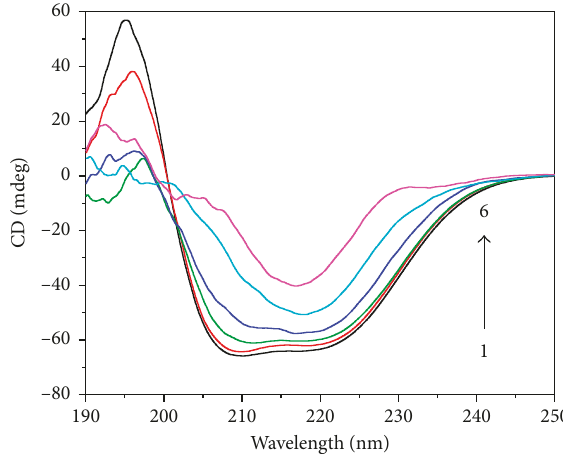
Figure 7: Far-UV CD spectra of HSA-compound system (HSA 20 µ M) in the presence of various concentrations of [Ag(I) (cid:29) (Hnor) 2 ]ClO 4 complex. Curves from 1 to 6 correspond to com- pound concentrations of 0, 20, 40, 60, 80, and 100 mM,